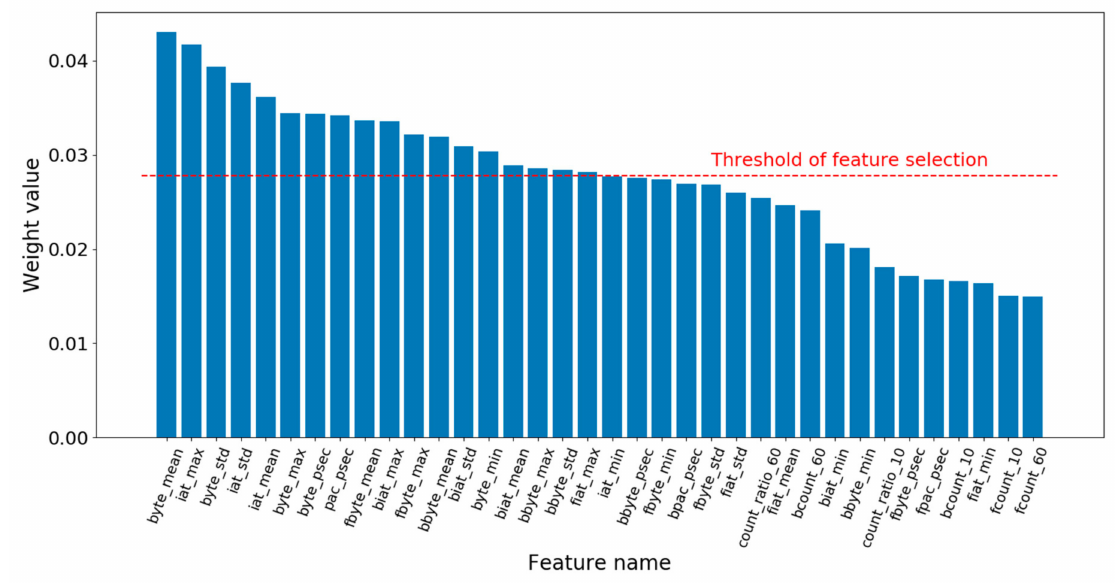
Figure 11. Accuracy of FCE-KNN for identifying content type of encrypted flows with di ff erent values of nRound 3 or δ 3 : ( a ) Accuracy under di ff erent nRound 3 ; ( b ) Accuracy under di ff erent δ 3 .